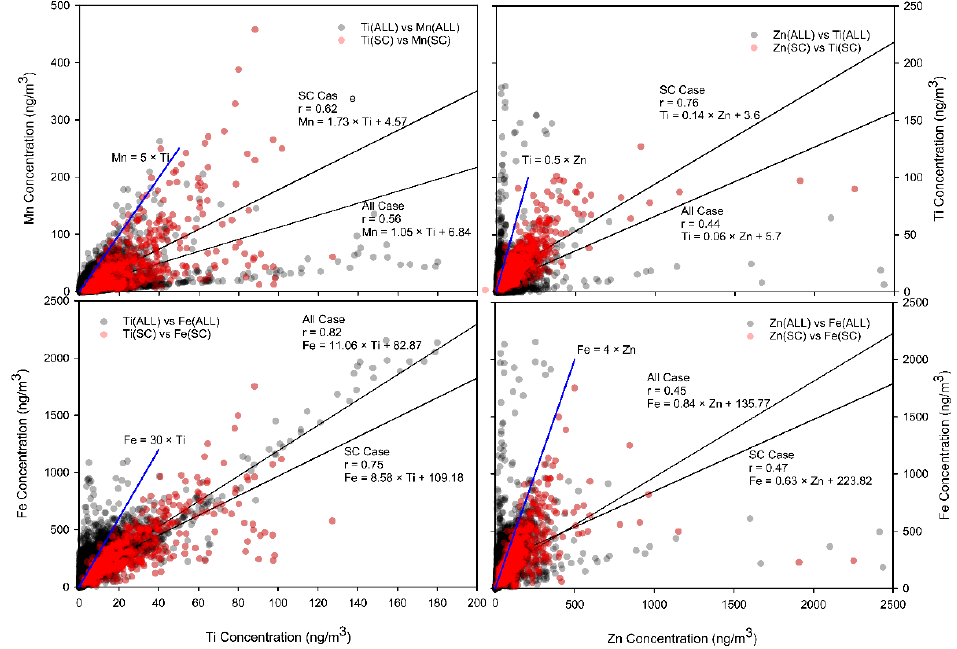
Figure 6. Correlations between heavy metals in all cases (ALL) and SCs.